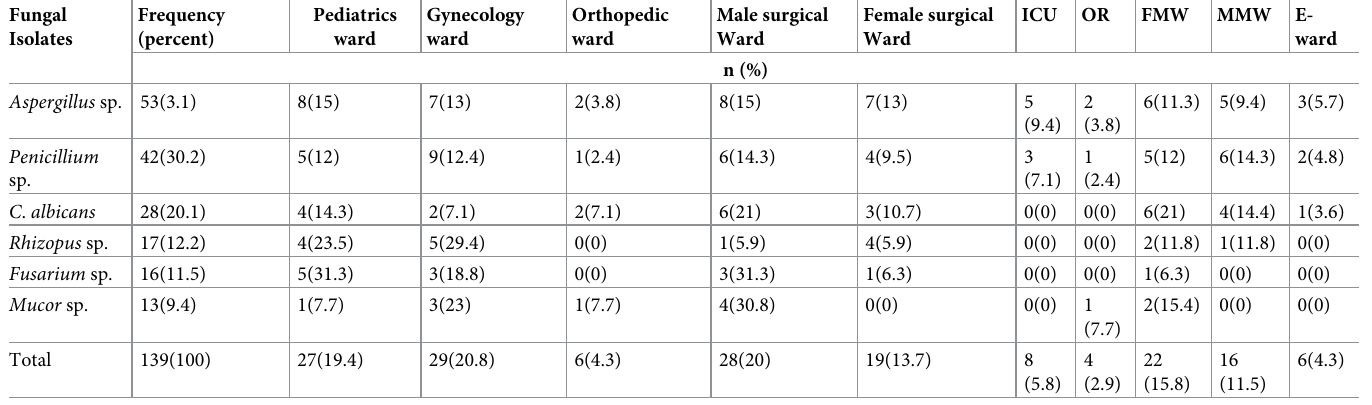
ICU OR FMW MMW E-